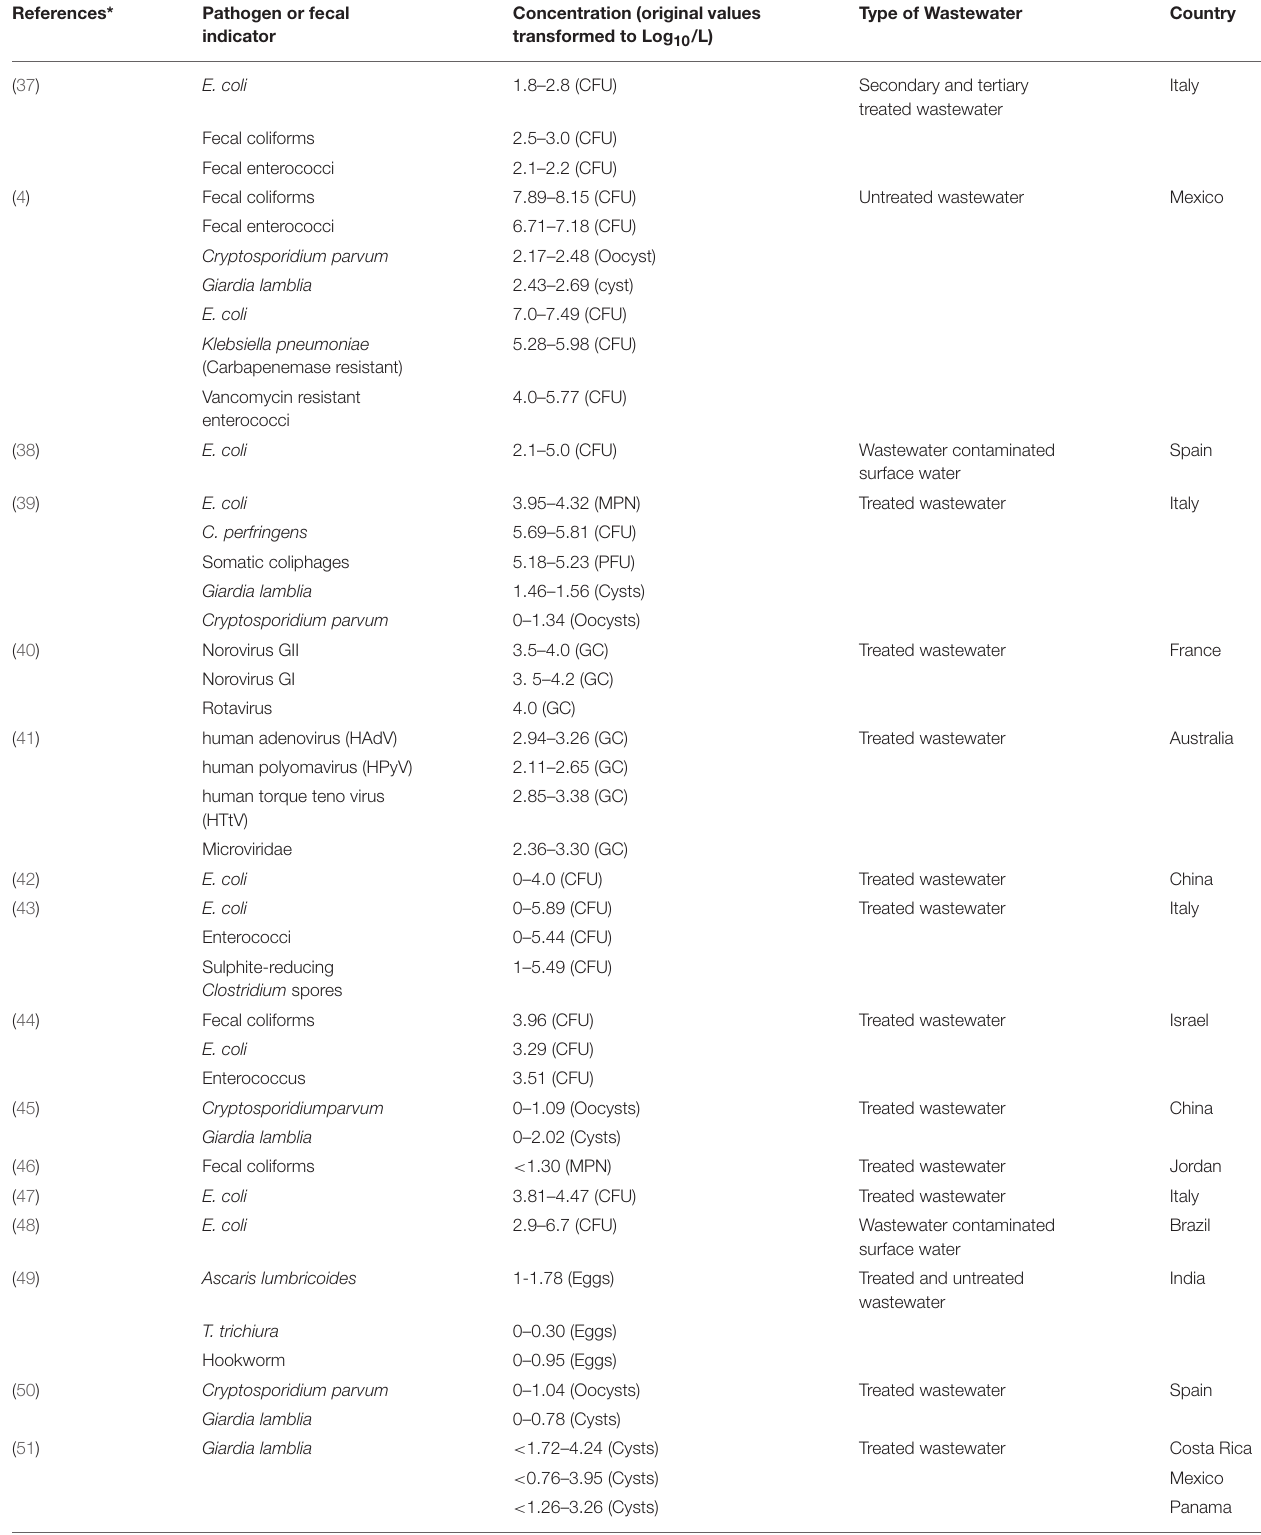
TABLE 1 | Concentration of fecal indicator organisms and pathogens reported in selected literature from different types of wastewater used for